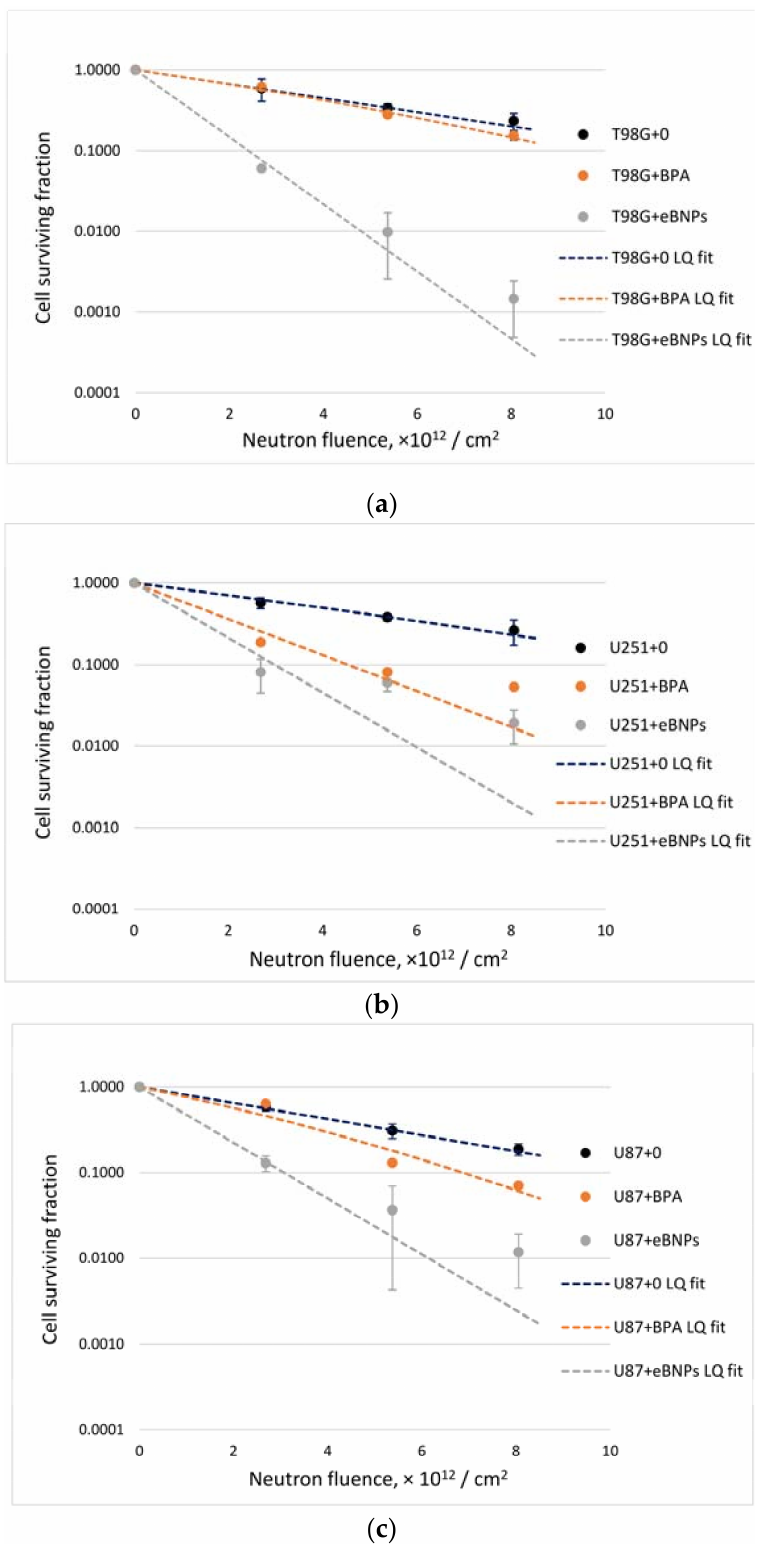
Figure 5. Cancer cell survival after BNCT. T98G ( a ), U251 ( b ) and U87 ( c ) cells were treated with eBNPs or BPA (40 µ g 10 B/mL), or left untreated (0), and irradiated with neutron fluences of 2.685, 5.370, or 8.055 × 10 12 /cm 2 . After dilution, seeding, and 14-day incubation, colonies of ≥ 50 cells were counted. The mean values of the cell survival fractions are plotted as curves with the error bars representing standard